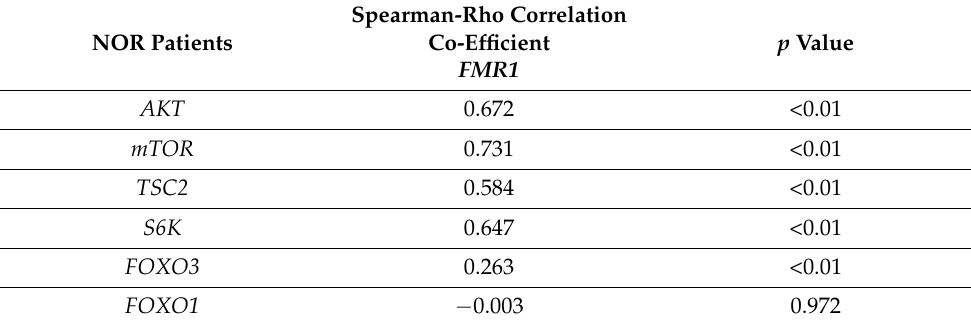
Table 3. Correlations of FMR1 gene expression with AKT1 , FOXO3 , FOXO1 , mTOR , TSC2 , and S6K expressions according to ovarian response group (NOR). The relative gene expression in granulosa cells of patients was normalized by two housekeeping genes and a granulosa cell calibrator using the ∆∆ Ct method. Correlation was calculated using the Spearman–Rho correlation coefficient.